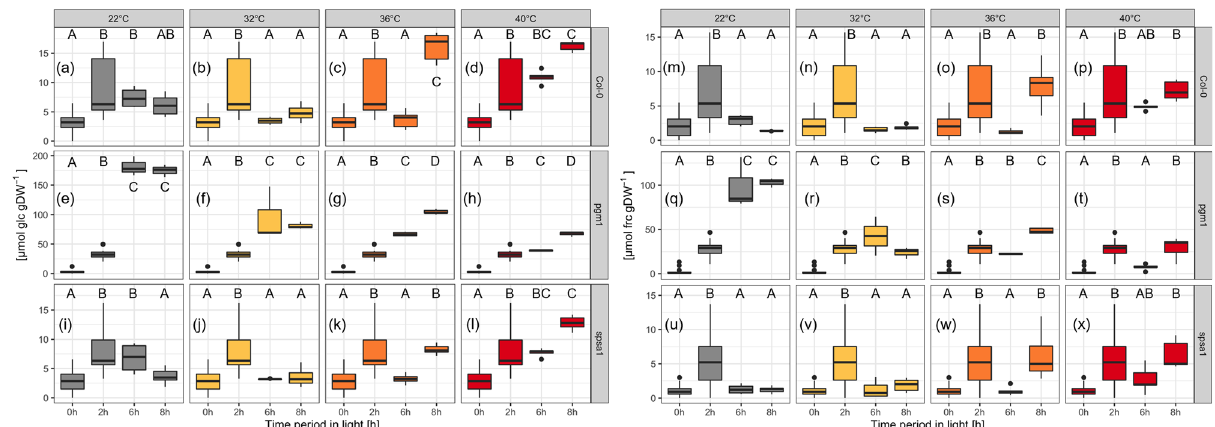
Fig. 7 Hexose concentrations during short-day transient heat exposure. Range of the y axes differs for pgm1 due to the high difference in concentration. a – l Glucose concentrations; a – d Col-0 ( n ≥ 5); e – h pgm1 ( n ≥ 3); i – l spsa1 ( n ≥ 5). m – x Fructose concentrations. m – p Col-0 ( n ≥ 5); q – t pgm1 ( n ≥ 3); u – x spsa1 ( n ≥ 5). Gray: 22 °C experiment; yellow: 32 °C experiment; orange: 36 °C experiment; red: 40 °C experiment. The temperature was set to 22 °C between 0 – 2 h and 6 – 8 h. The temperature was transiently increased between 2 and 6 h. Box-and-whisker plots: center line, median; box limits, upper and lower quartiles; whiskers, 1.5× interquartile range; points, outliers. Capital letters indicate groups of signi fi cance within genotype and condition (ANOVA, P < 0.05). Experimental data are provided in Supplementary Data